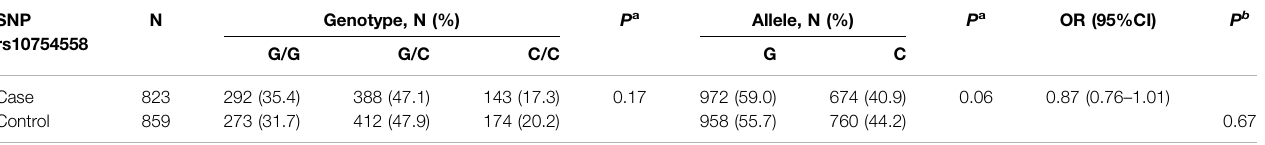
TABLE 1 | Distribution of rs10754558 genotypes and alleles in schizophrenia patients and healthy